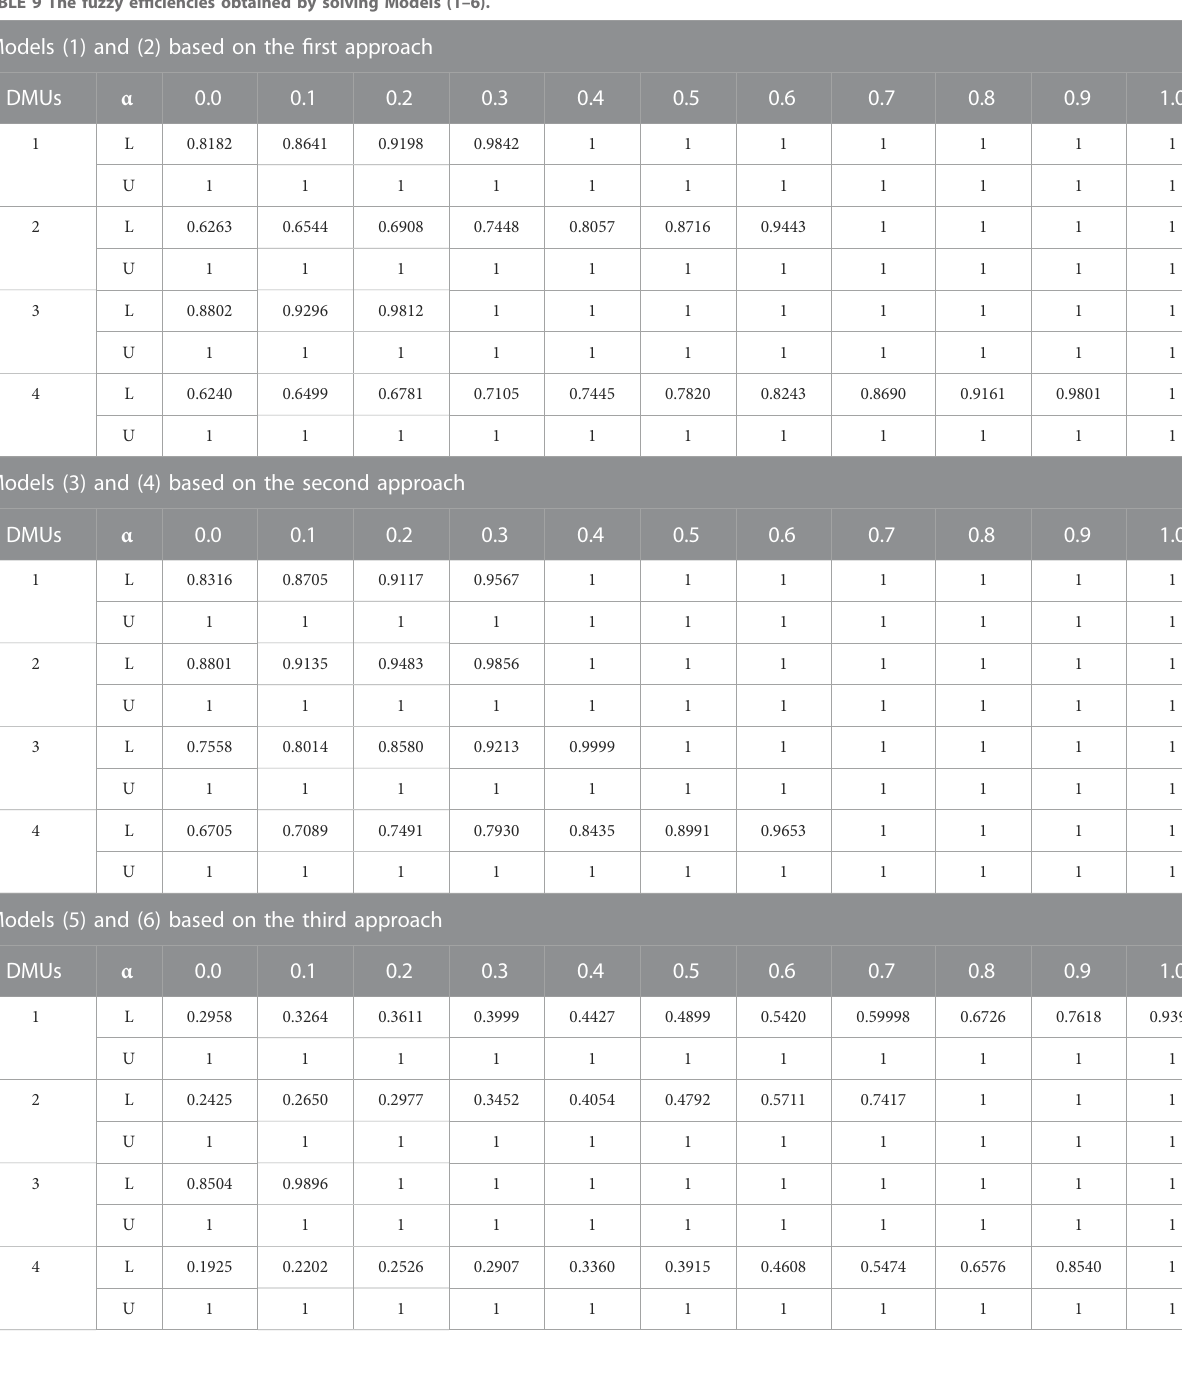
Models (3) and (4) based on the second approach